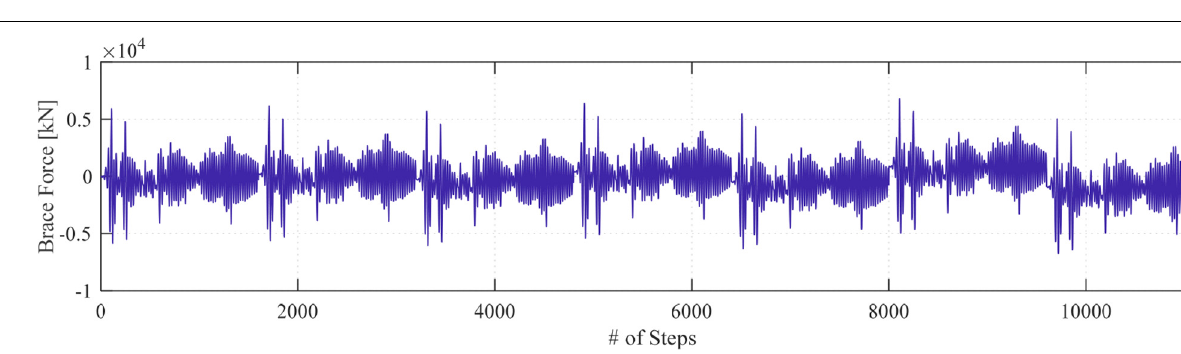
FIGURE 8 | Stacked ground motion acceleration dataset (Input 1).